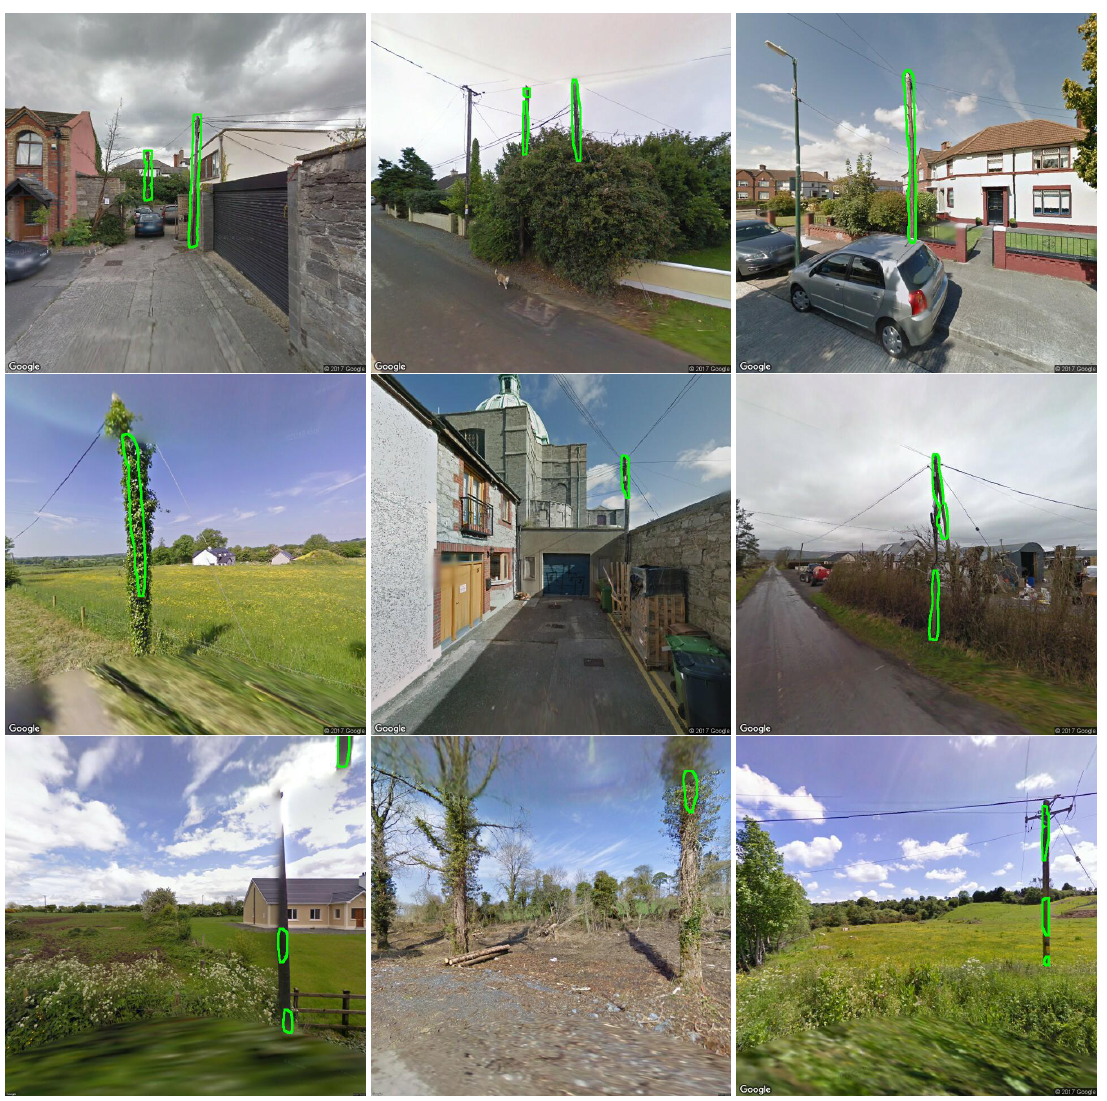
Figure 7. Telegraph pole segmentation on Google Street View (GSV) images. First row: correct segmentation. Second row: partial detection. Third row: poor detection due to strong stitching (left) and false positives: ivy-covered tree and electricity